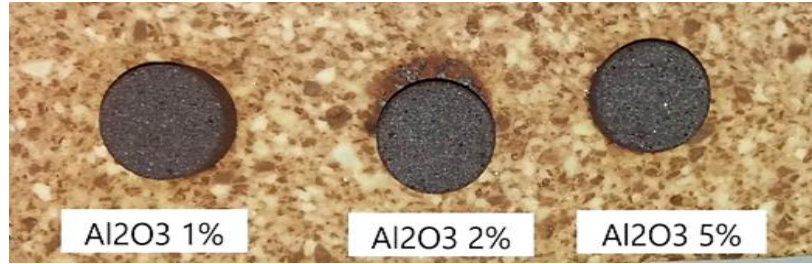
Figure 10. Peridotite sample E6743 with the CaO addition after calcination.